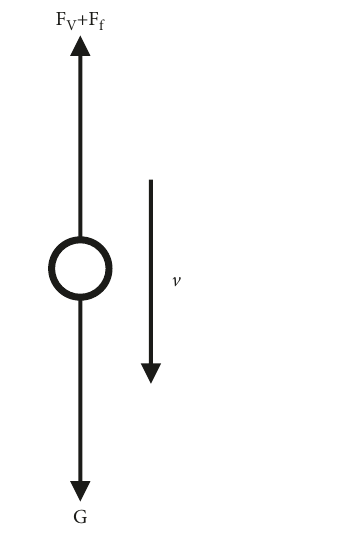
Figure 1: Stress analysis of